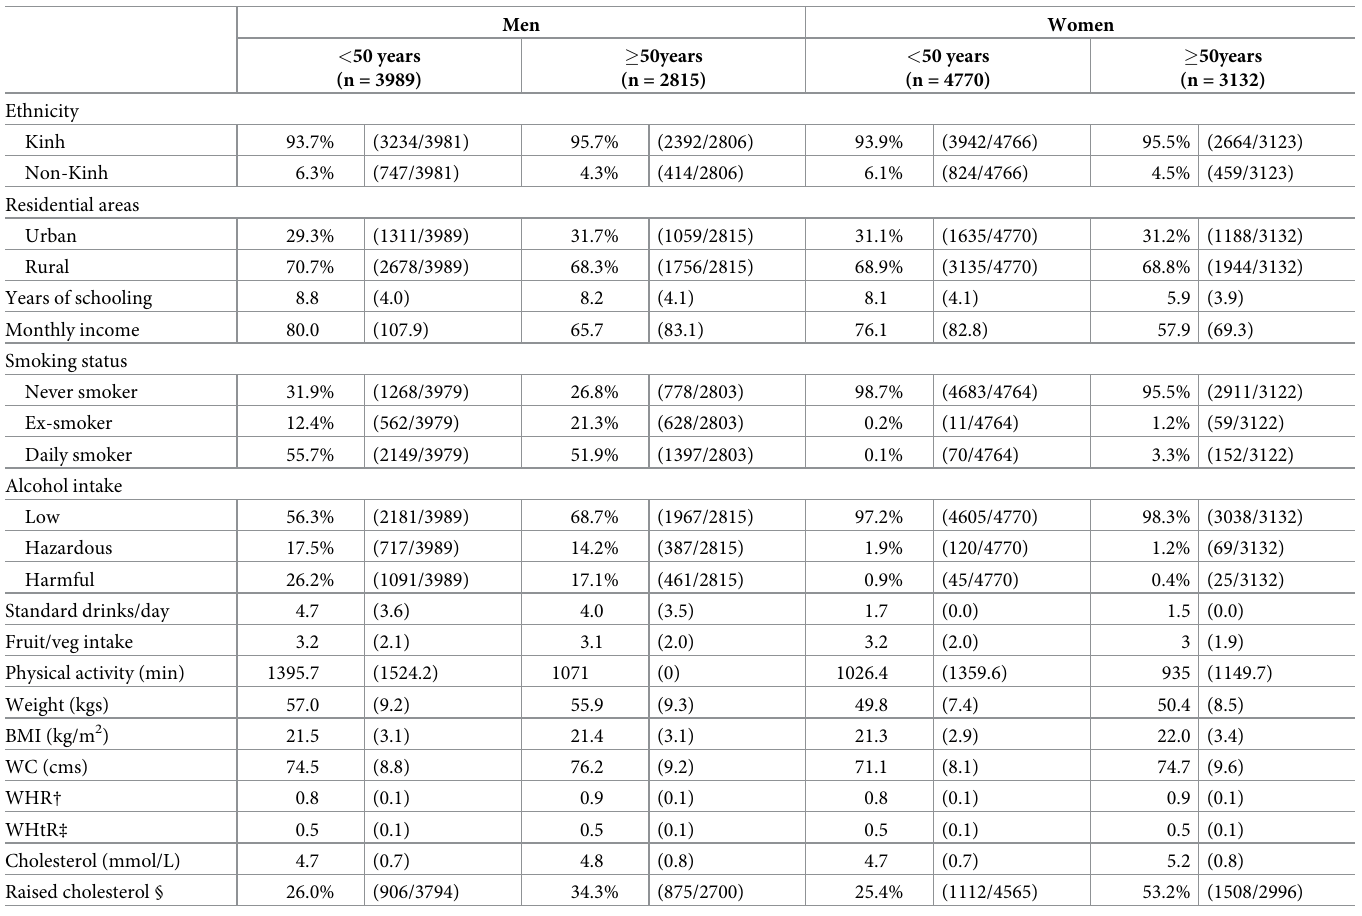
Table 1. Characteristics � of survey